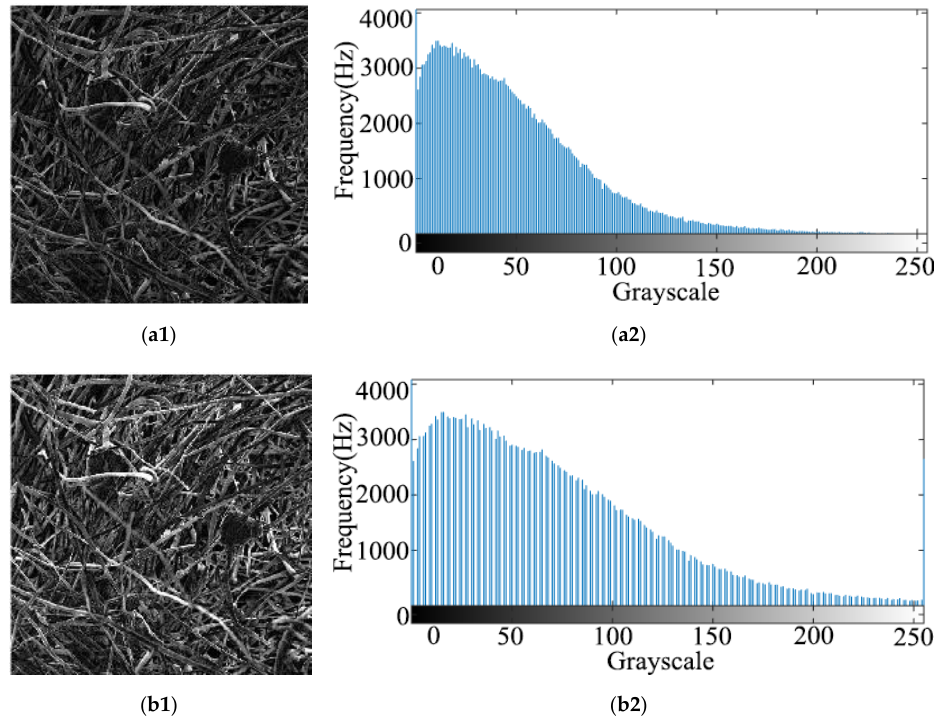
Figure 7. The gray scale image and grayscale histogram before and after grayscale stretching: ( a1 ) Original grayscale image ( a2 ) Original grayscale histogram ( b1 ) Grayscale stretch e ff ect image ( b2 ) Histogram of grayscale stretched